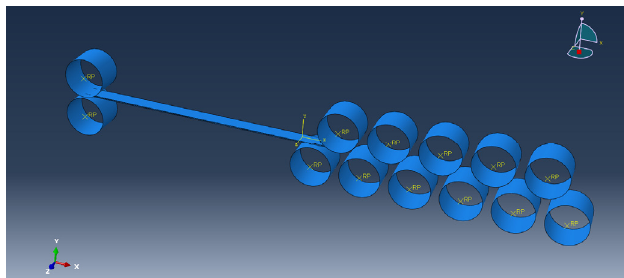
Figure 4. Schematic diagram of 11-roll straightening model.